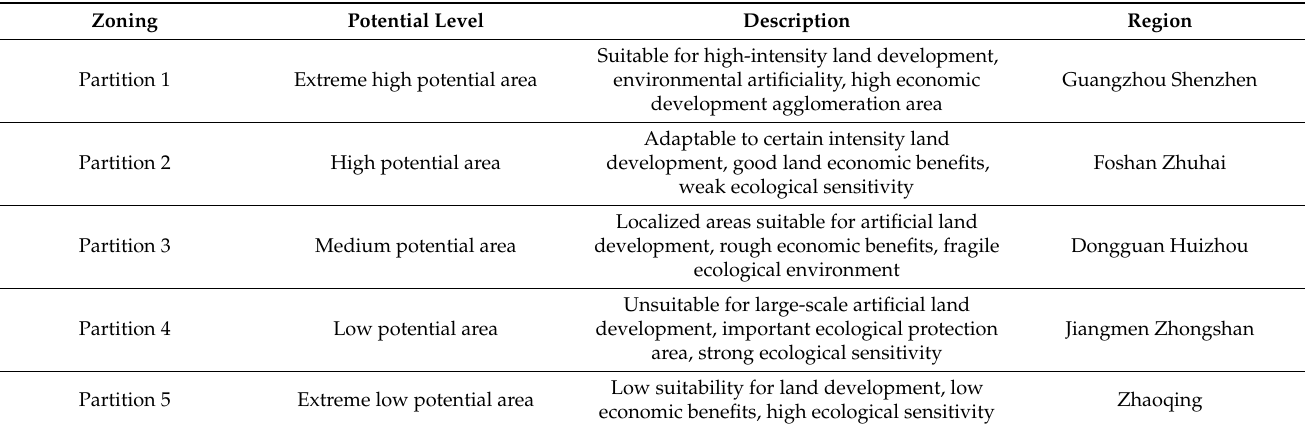
Table 5. Results of land development potential